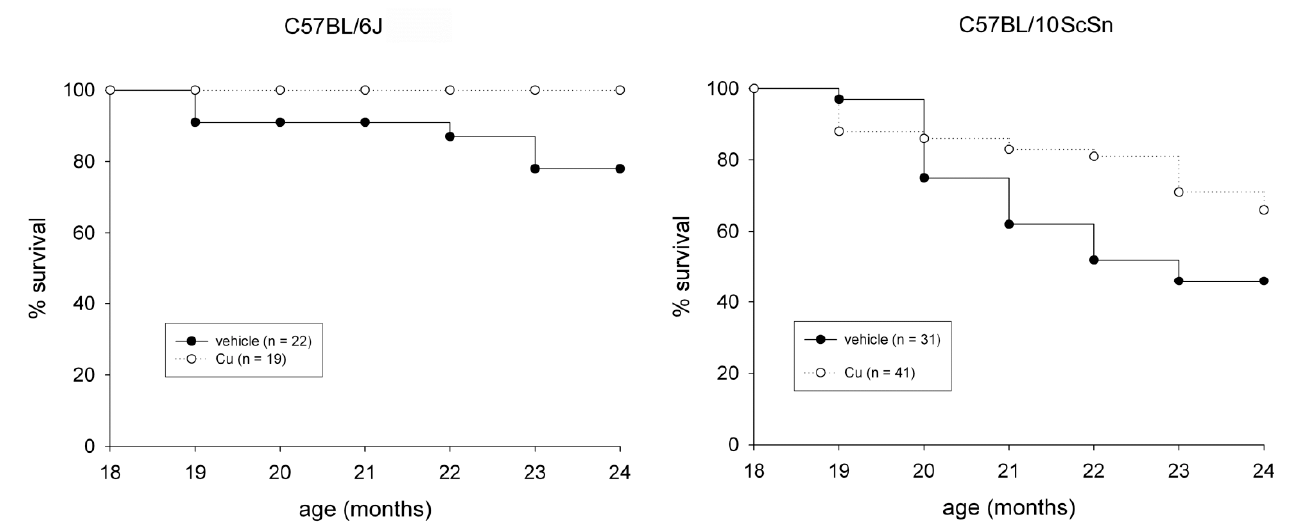
Figure 1. Survival plots of vehicle-treated (closed circle) and curcumin-treated (open circle) of C57BL6J and C57BL10ScSn mouse strains between 18- and 24-months of age. n indicates total number of mice for each group. Statistical analysis log-rank (Mantel-Cox) test p ≤ 0.04.